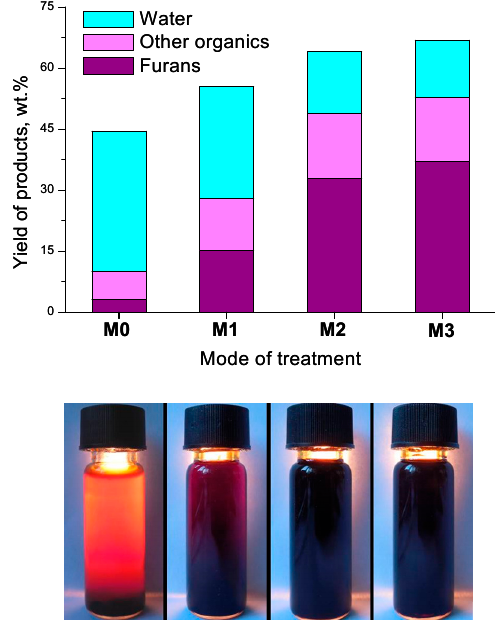
Figure 7. Yields, average fractional composition and photos of condensates, obtained from microcrystalline cellulose (Dose: M1—2 MGy; M2—550 kGy; M3—75